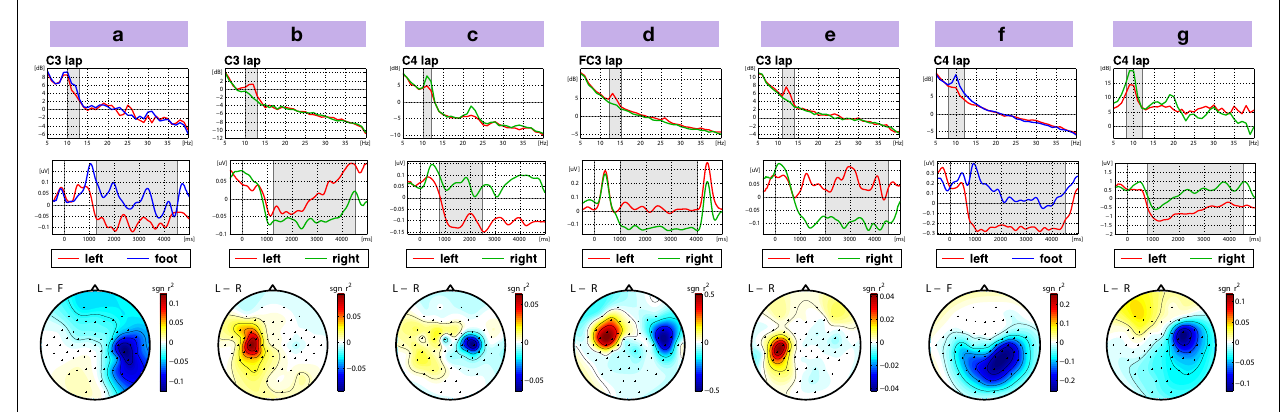
spectra shown above is shaded.The bottommost row displays the (signed) r 2 -difference in log band-power between the individually chosen motor imagery tasks as scalp maps. Band-power was calculated in the frequency band that is shown in the topmost row and averaged across the time interval that is indicated in the middle row.Three of those seven data sets have been artificially generated, see main